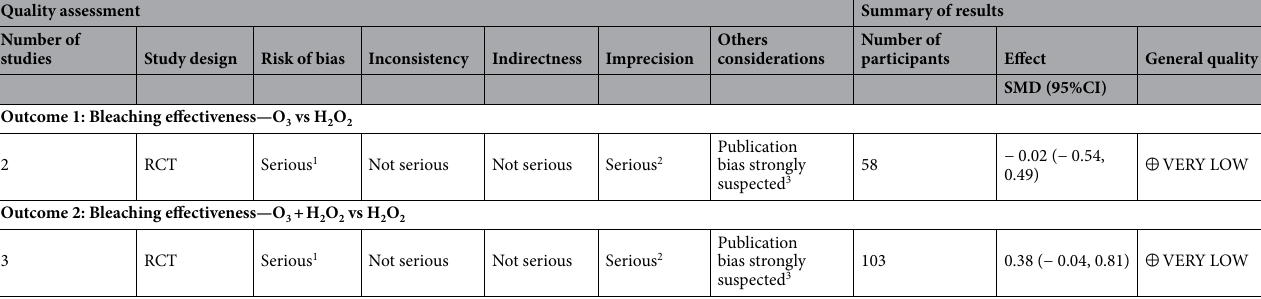
Table 5. Summary of findings by the Grading of Recommendations Assessment, Development, and Evaluation (GRADE) for the outcomes of the systematic review and meta-analysis. GRADE Working Group grades of evidence. High certainty: We are very confident that the true effect lies close to that of the estimate of the effect. Moderate certainty: We are moderately confident in the effect estimate: The true effect is likely to be close to the estimate of the effect, but there is a possibility that it is substantially different. Low certainty: Our confidence in the effect estimate is limited: The true effect may be substantially different from the estimate